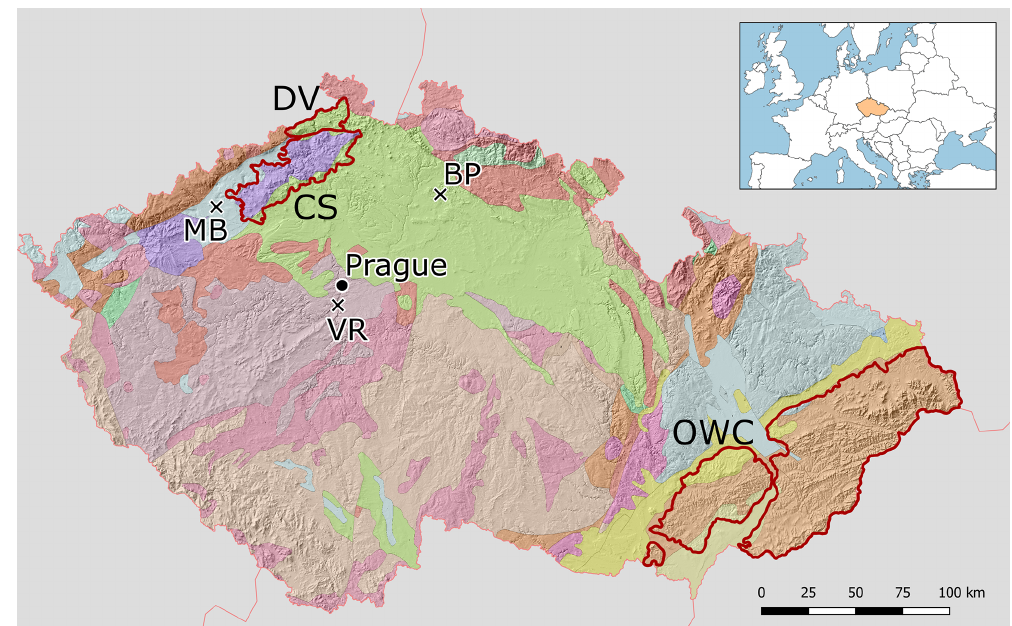
Figure 1. Delimitation of the primary areas where landsliding concentrates in Czechia. Neogene volcanic rocks (CS – ˇCeské stˇredohoˇrí Mts), Mesozoic sandstones (DV – Dˇeˇcínská vrchovina), Neogene and Quaternary sediments (MB – Most Basin) on the west, Mesozoic sandstones in central parts of Czechia (BP – Bohemian Paradise sandstones), and Mesozoic and Tertiary flysch belt (OWC – Outer Western Carpathians) in the east of Czechia represent the most susceptible parts to landsliding. VR – concentration of rockfalls along the Vltava River; https://mapy.geology.cz/arcgis/rest/services/Inspire/GM2_5mil/MapServer (last access: 19 August 2021; Czech Geological Survey Map Server, 2012b). © Czech Geological